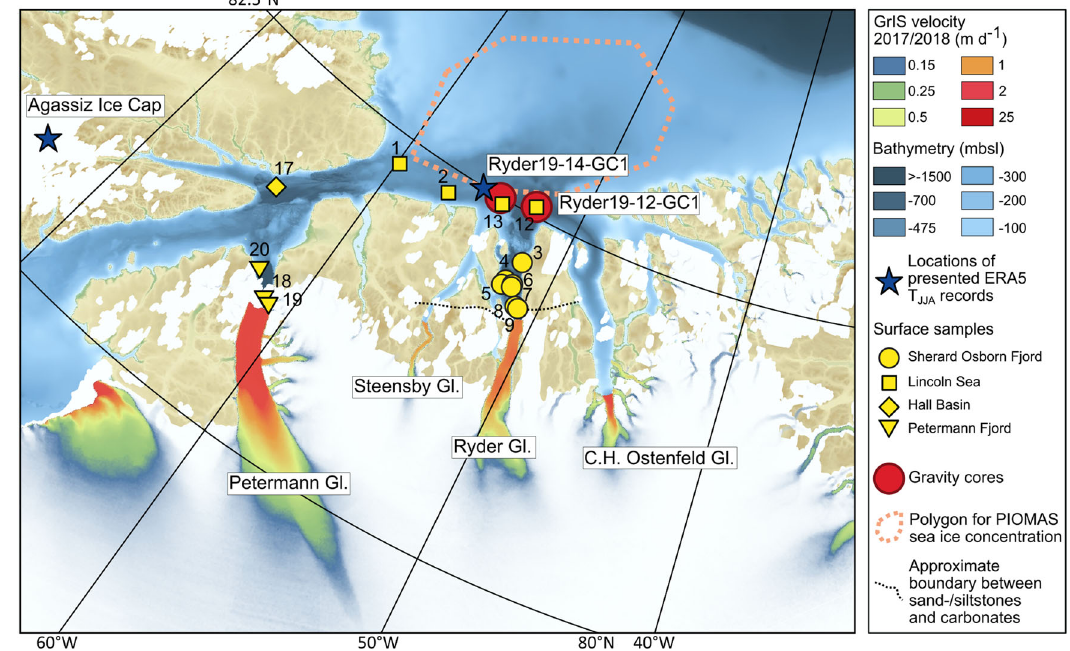
Fig. 4 Southern Lincoln Sea and northern Nares Strait including locations discussed in the manuscript. Surface samples (yellow symbols with area- coded shape) are numbered according to the respective multi-corer station. The locations of gravity core 12-GC and 14-GC are marked with red dots. Additionally the bathymetry (IBCAO v4) 96 and velocity of the GrIS 97 are shown and the major glaciers of the region and locations of presented temperature records (blue stars) are marked. The dashed black line marks the approximate boundary of sand-/siltstones and carbonates in the region surrounding Sherard Osborn Fjord 75